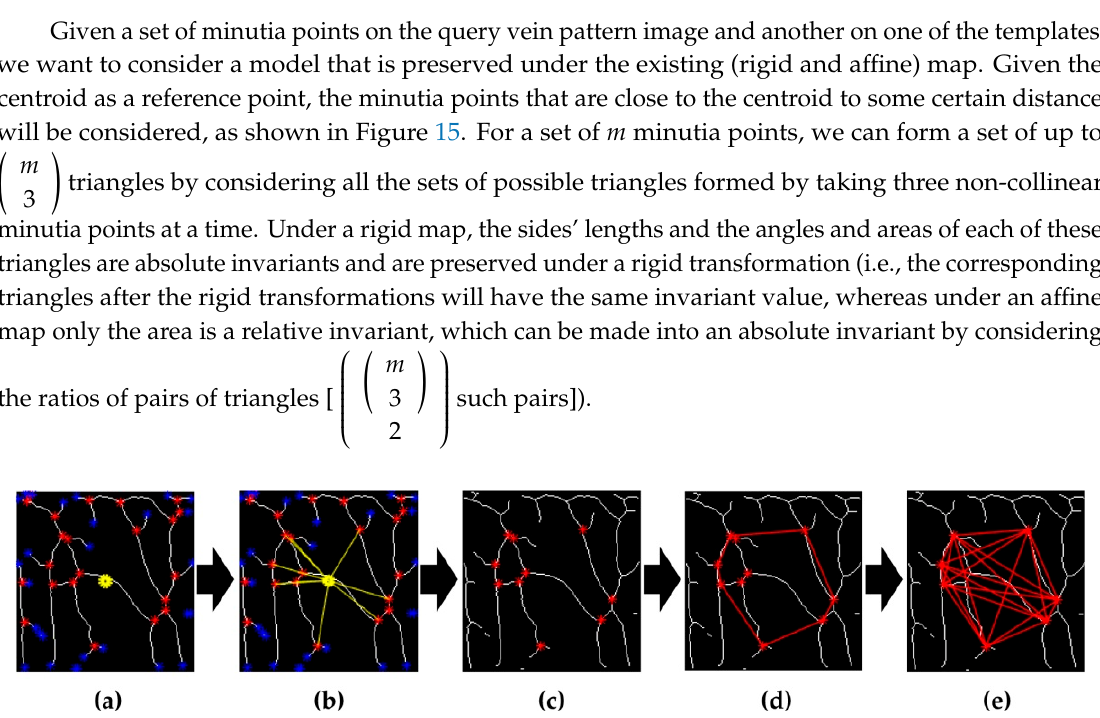
Figure 15. Triangulation on the set of minutia points close to the centroid: ( a ) determination of the centroid of vein pattern image; ( b ) calculation of the distance between minutia points and centroid; ( c ) selected ten closing minutia points; ( d ) local convex hull from the selected minutia set; and ( e ) forming triangles from the selected minutia set.